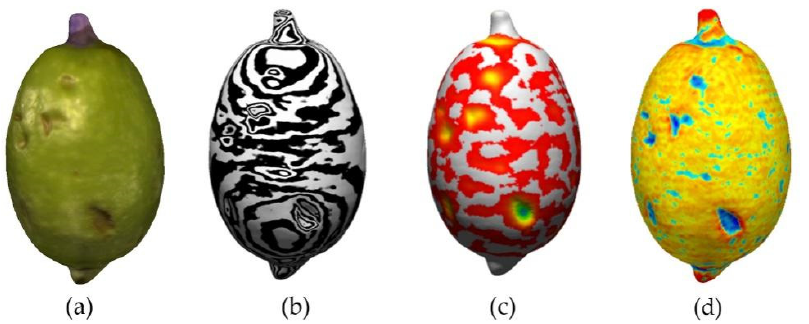
Figure 5. Curvature map of the mesh: ( a ) 3D mesh texturing; ( b ) zebra curvature; ( c ) curvature 1, and ( d ) curvature 2.